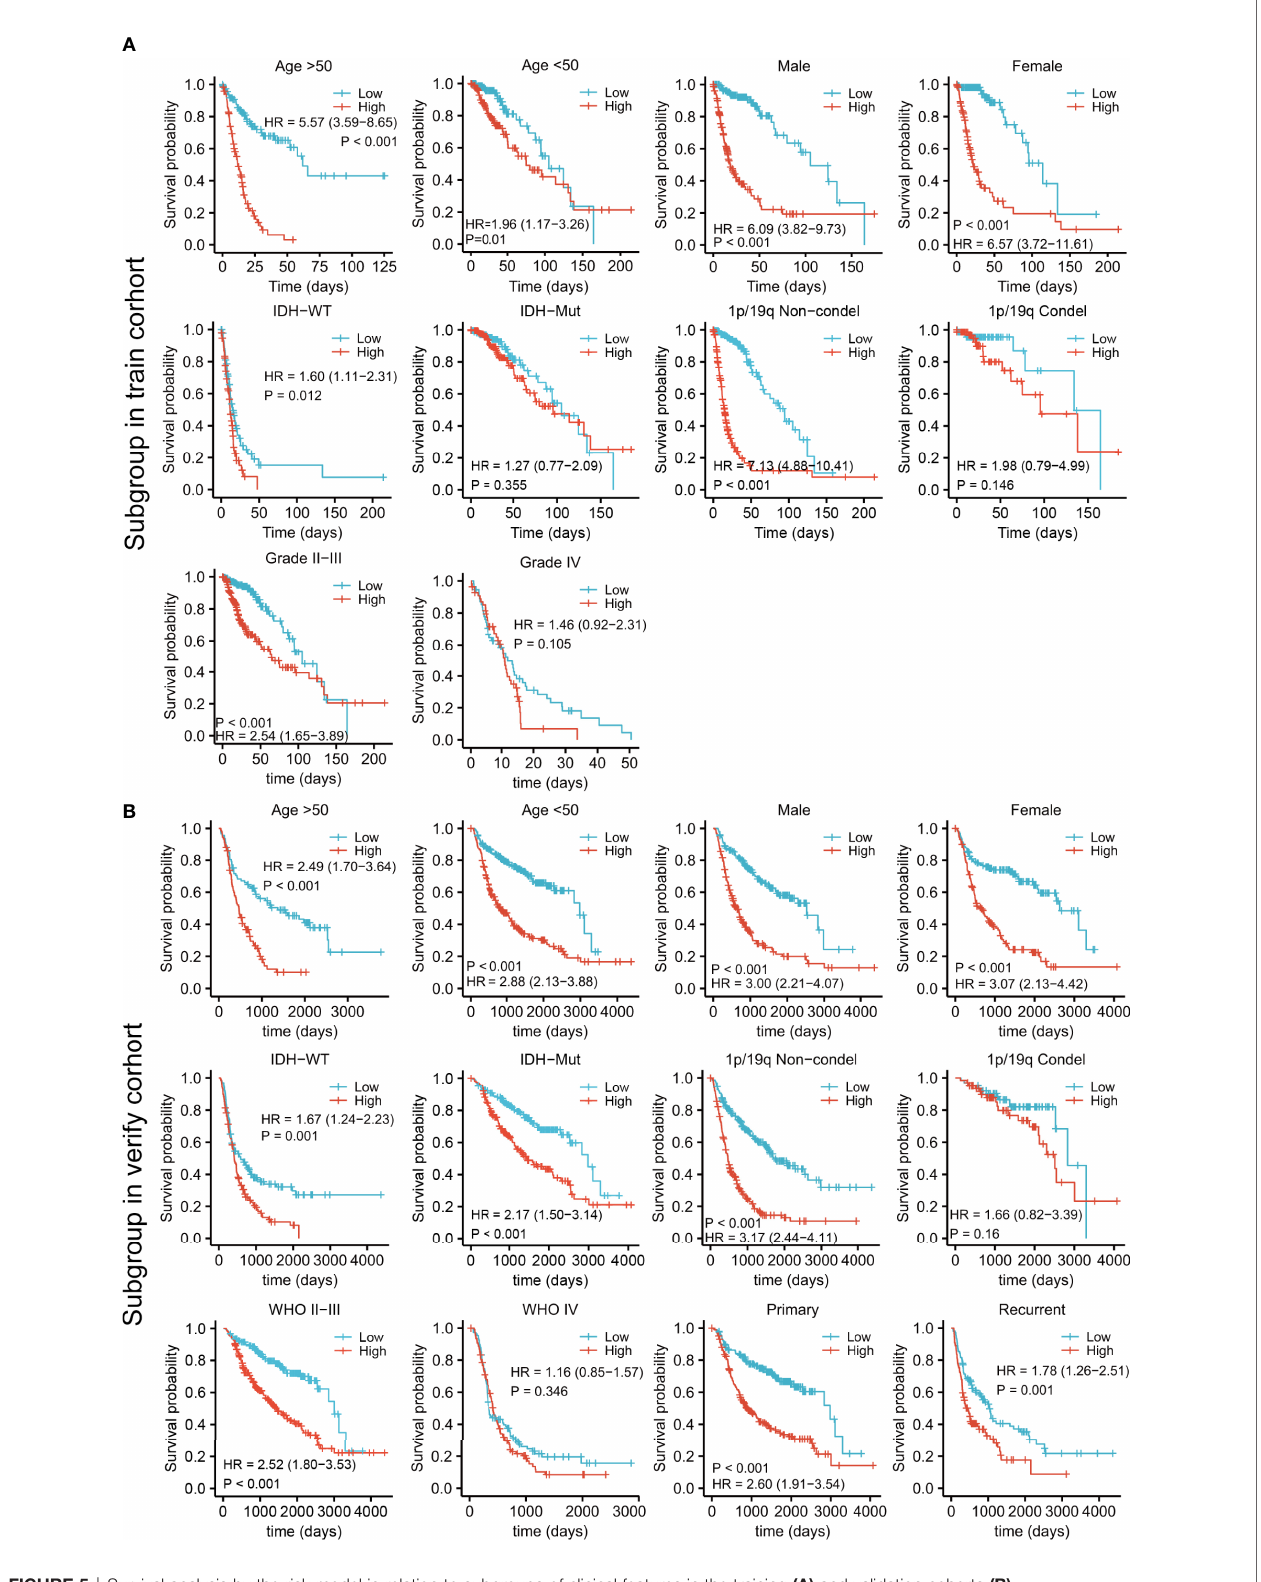
FIGURE 5 | Survival analysis by the risk model in relation to subgroups of clinical features in the training (A) and validation cohorts (B)